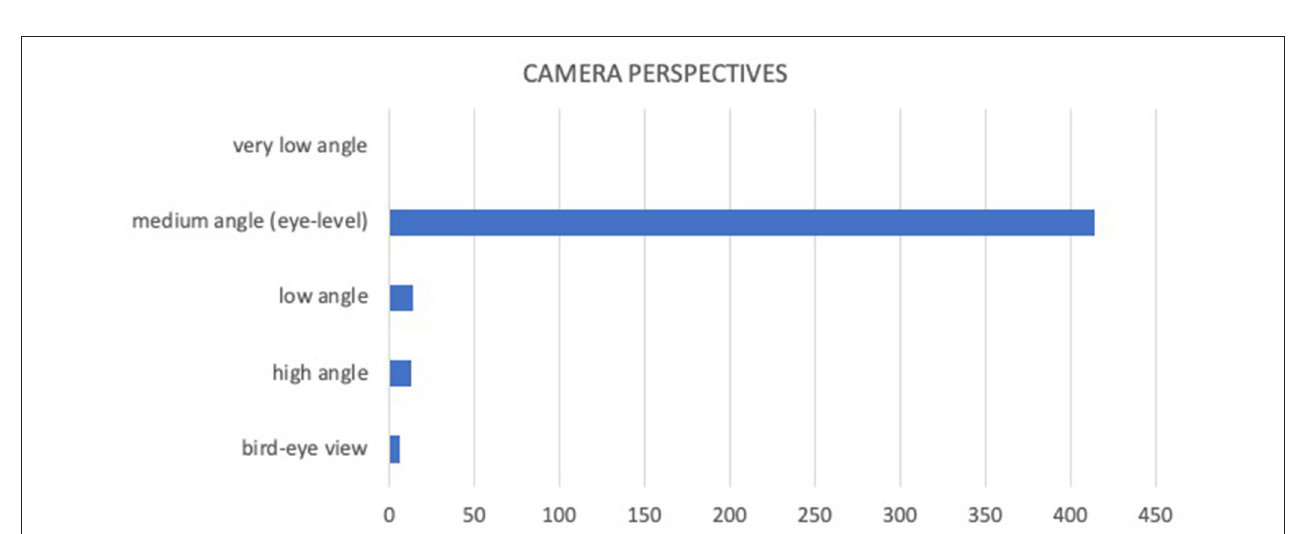
FIGURE 8 | Overview of camera perspectives used in all shots of the Heineken